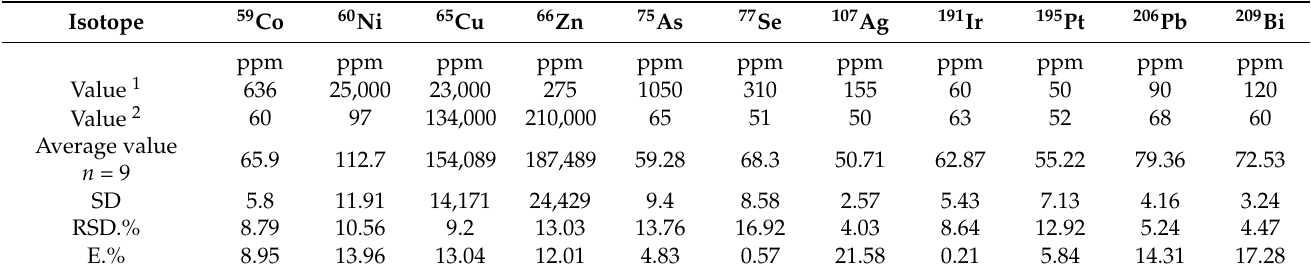
Table A1. Results of the RSM measurements for estimation of the accuracy and precision of the LA-ICP-MS